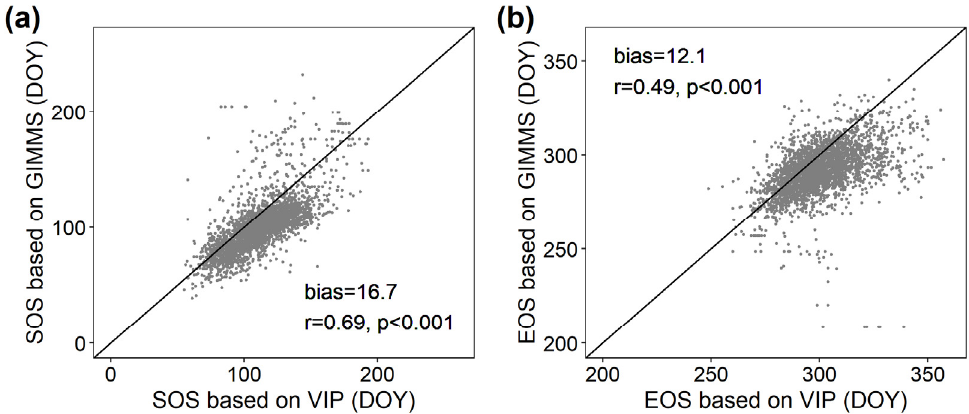
Figure 4. Comparison of ( a ) SOS and ( b ) EOS derived from VIP and GIMMS. DOY means the day of the year.